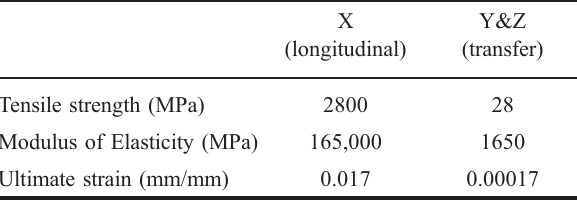
Table 2. CFRP sheet properties in three dimensions